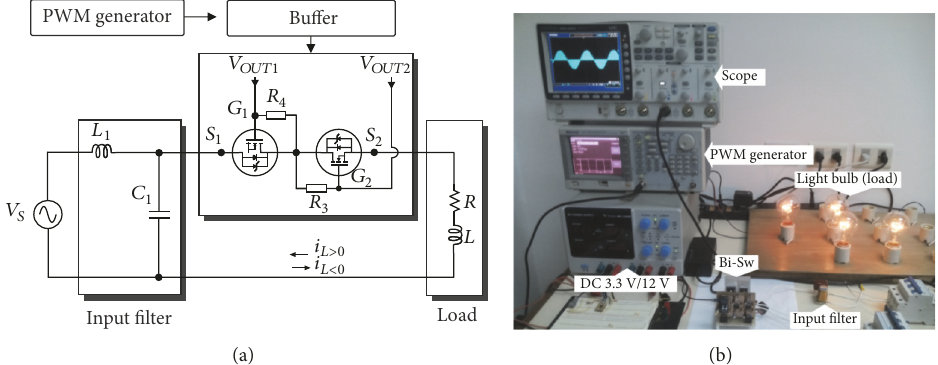
Figure 5: Electrical diagram of the ac voltage regulator and the experimental setup. (a) Electrical diagram of the prototype of ac voltage regulator (test circuit). (b) Experimental setup of the ac voltage regulator.